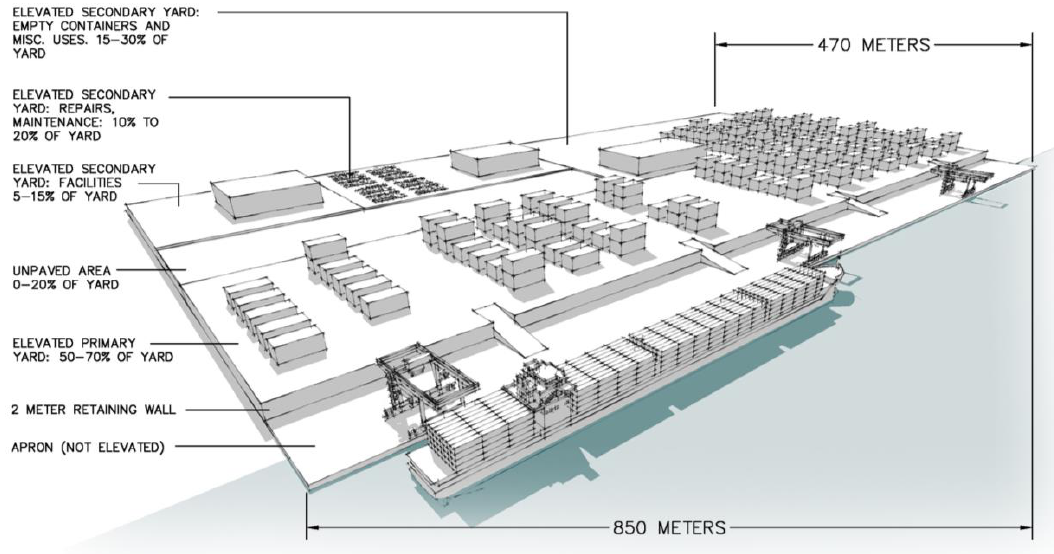
Figure 1. Schematic layout of GenPort with three area components included in the cost estimate (image by authors).